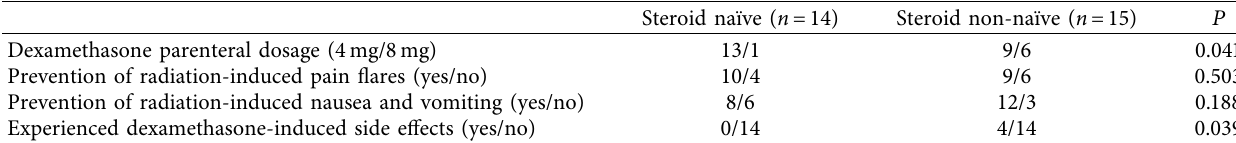
Table 2: Dosage, efcacy, and safety of implemented dexamethasone